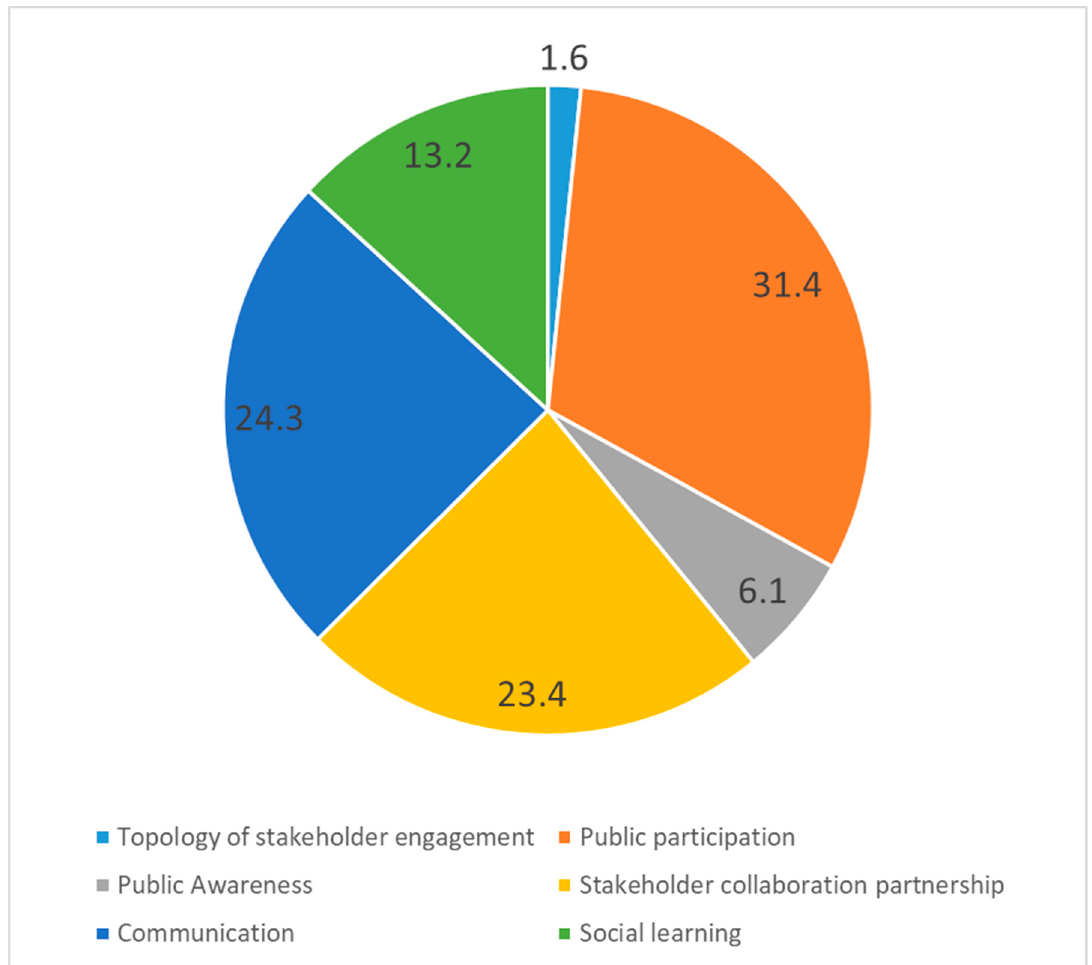
Figure 4. Search records from Google Scholar ® for the stakeholder engagement with different sub-topics in percentage (%).